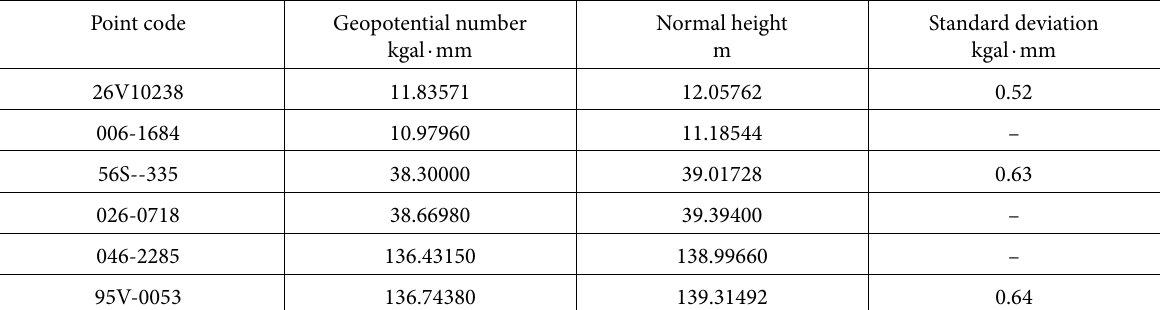
Table 9. Normal heights of border benchmarks Point